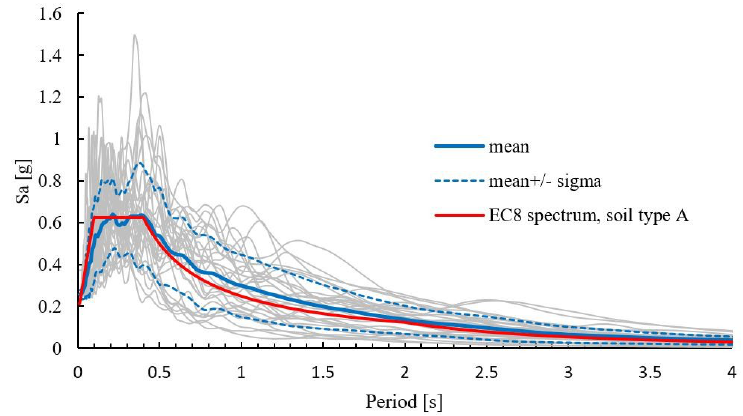
Figure 3. Response spectra (5% damping) of the selected set of GMs used in the fragility analysis.